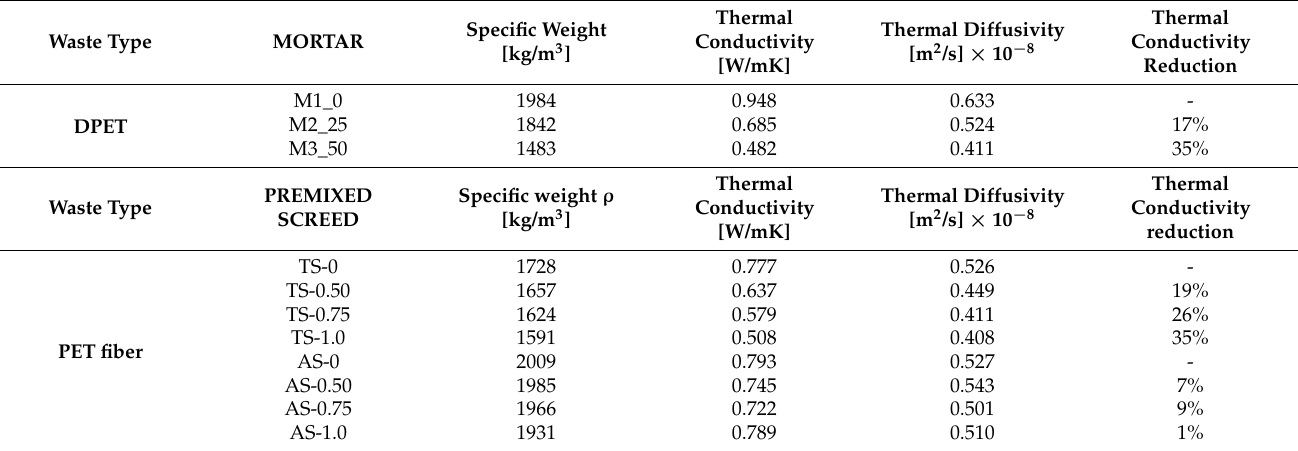
Table 4. Speci fi c weight, thermal conductivity, and di ff usivity values of DPET mortars and PET- fi ber screeds investigated.